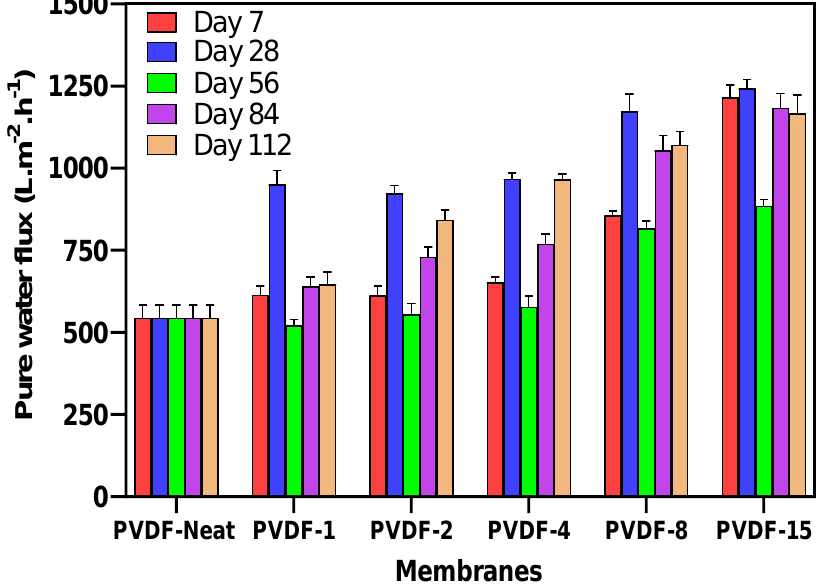
Figure 10. Permeate flux of neat and embedded membranes in varying sulfuric acid concentrations at different immersion periods. Table 2. Rejection study of neat and embedded PVDF membranes.